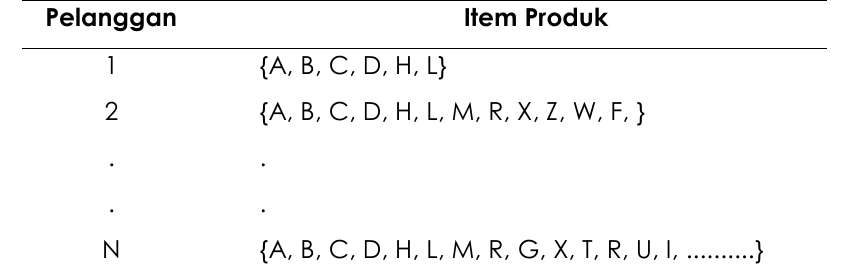
Tabel 1. Struktur Data untuk Market Basket Analysis